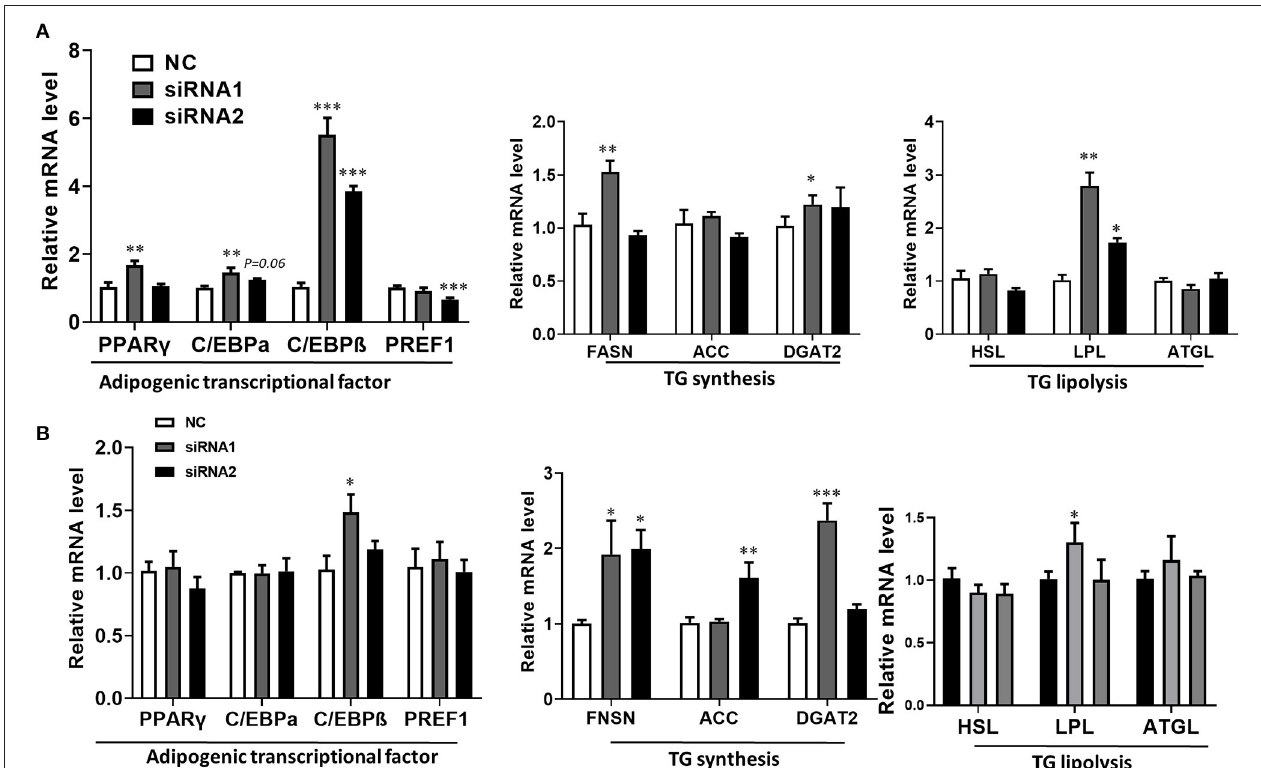
FIGURE 4 | Knockdown of LKB1 promotes adipogenic and lipid accumulation-related genes. (A,B) The mRNA level of adipogenic transcription factors ( PPAR γ , C/EBP α , C/EBP β , and PREF1 ), TG synthesis genes ( FASN , ACC , and DGAT2 ), and TG lipolysis genes ( HSL , LPL, and ATGL ) between control and siRNAs groups at day 2 (A) and day 4 (B) post-adipogenic induction. * P < 0.05, ** P < 0.01, *** P < 0.001, compared to that of control. FASN, fatty acid synthase; ACC, acetyl-CoA carboxylase alpha; DGAT2, diacylglycerol acyltransferase, HSL, hormone-sensitive lipase; LPL, lipoprotein lipase; ATGL, adipose triglyceride